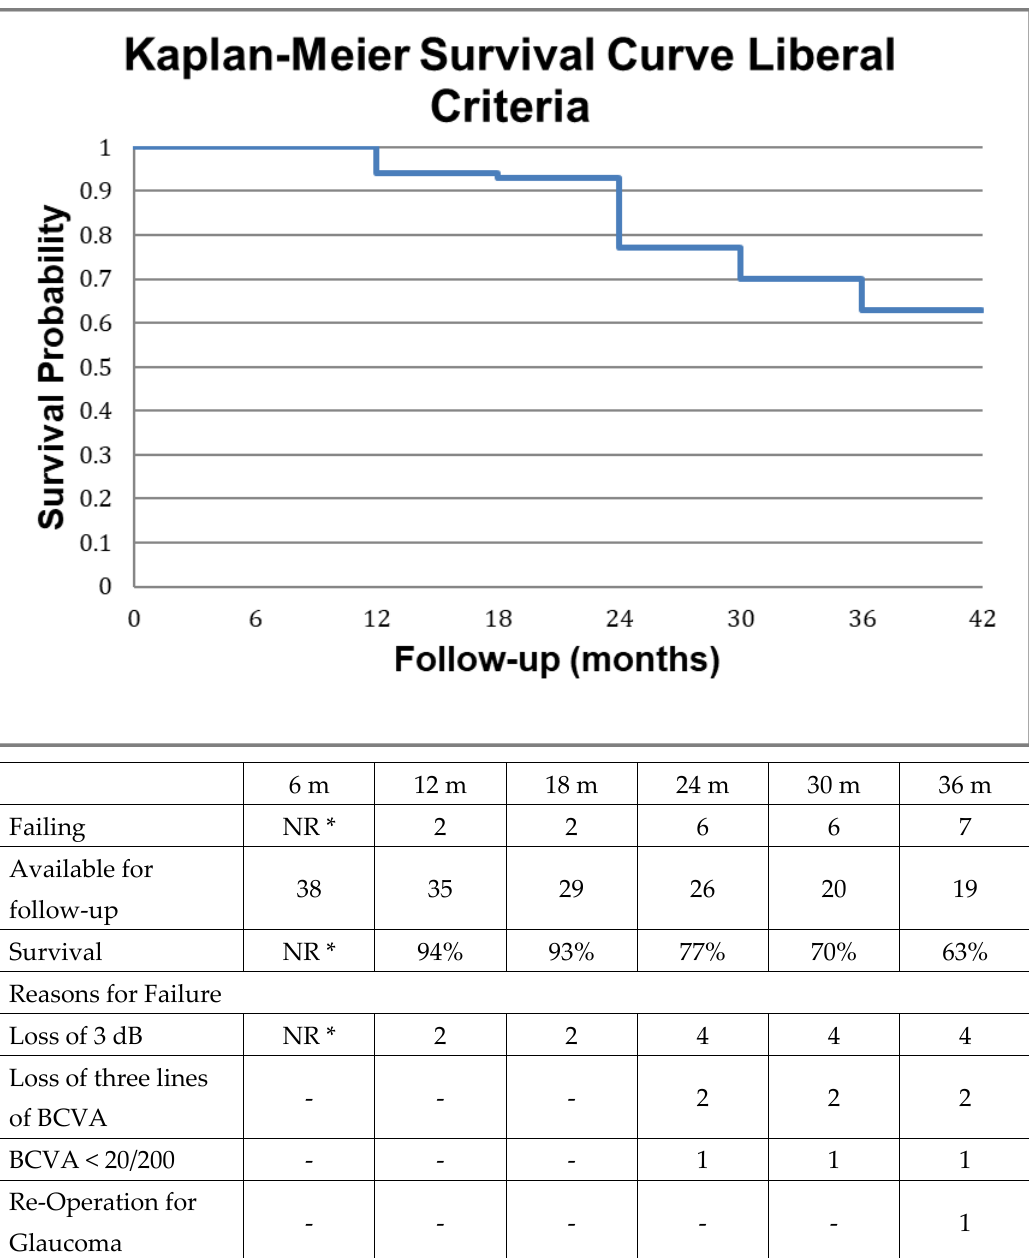
Figure 1. Survival of visual function according to the liberal criteria along with the reasons for failure as defined in the method section. Briefly, failure was defined as loss of 3 dBs in mean deviation in standard automated perimetry or loss of three lines in best corrected visual acuity or decline of Snellen best corrected visual acuity below the level of 20/200 or re-operation for glaucoma during the follow-up period. The individual reasons for failure may occasionally add up to more than the sum of failures because of patients failing for more than one reason. NR *: Not reported due to scarcity of VF data at 6 months.